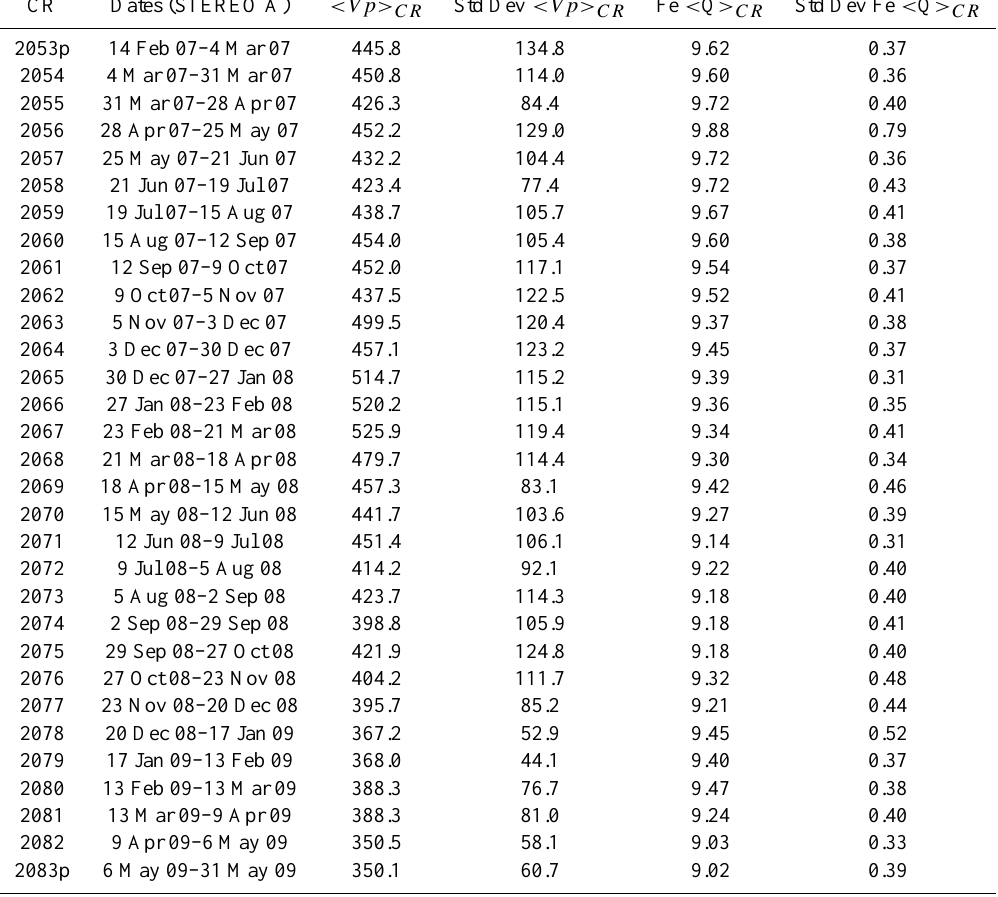
Table 1. Temporal trends in proton speed and iron average charge state (all